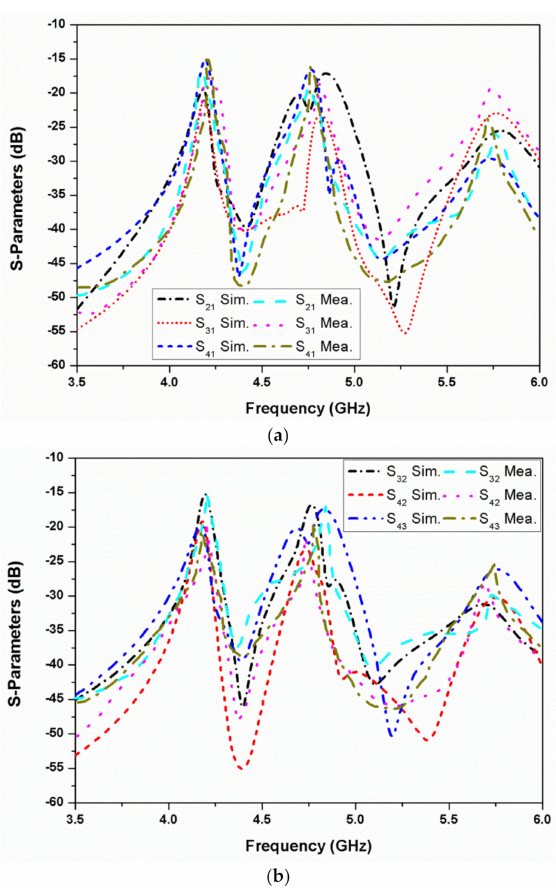
Figure 11. Simulated and measured S-parameters of the four-element stacked MIMO antenna: ( a ) when port 1 is excited; ( b ) when port 2/port 3 is